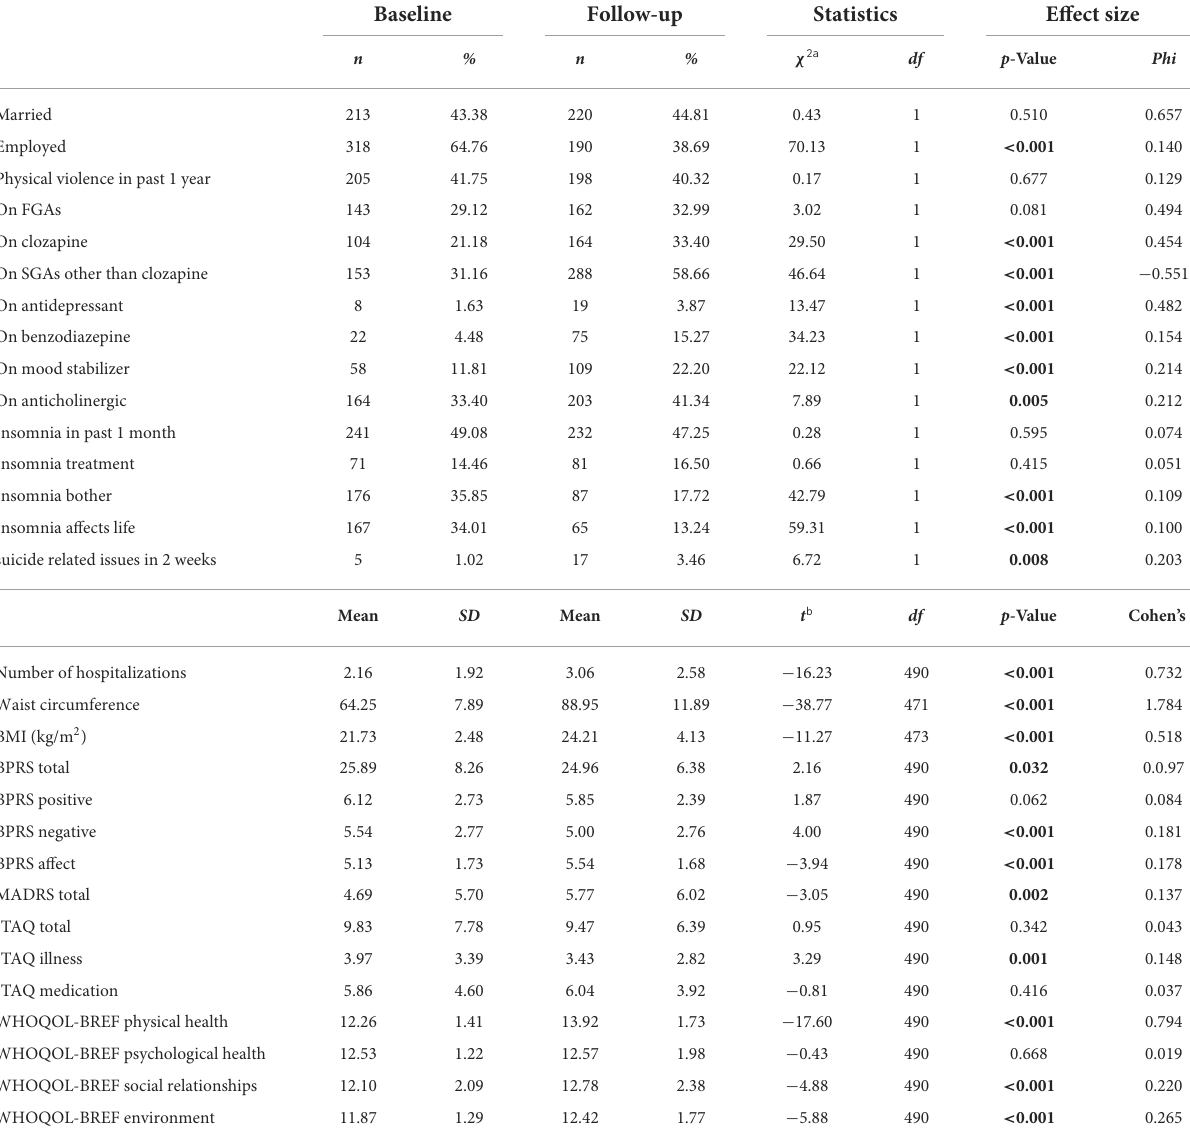
TABLE 2 Comparison of sociodemographic and clinical characteristics between baseline and 2 year follow-up in 491 patients with schizophrenia. Baseline Follow-up Statistics Effect